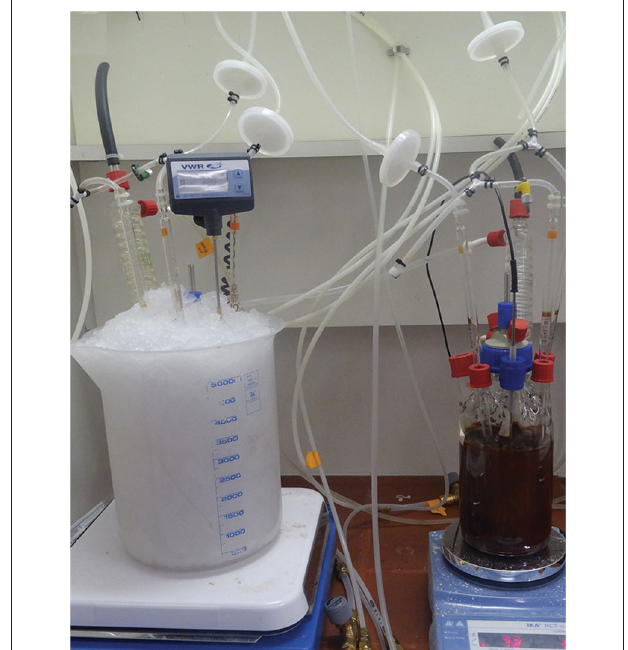
FIGURE 1 | Cultures of M. sedula at cold temperature regime. Fermentation set up for cultivation of M. sedula in 1L glassblower modified Schott-bottle bioreactors at 73 ◦ C (right) and at cold temperature regime in ice-supplemented environment with a tap water heat exchange system